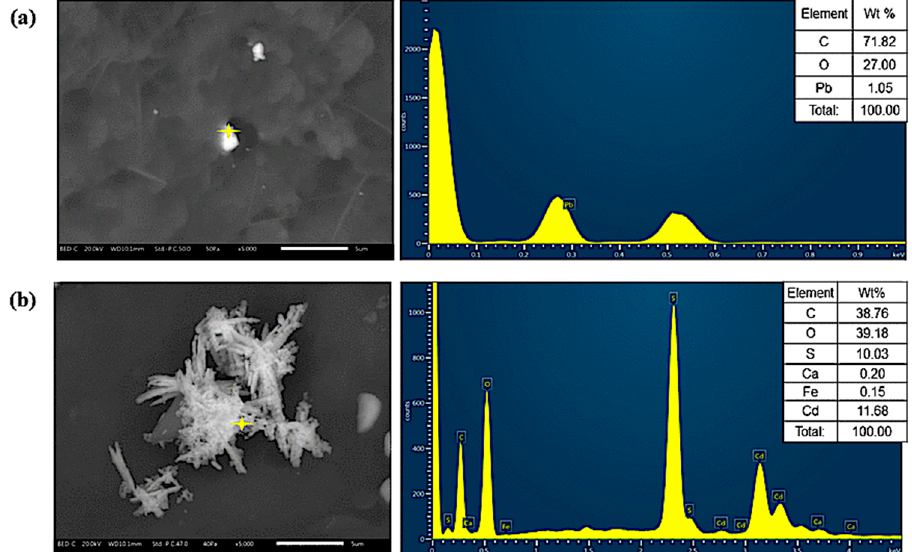
Figure 3. Spot analysis of composite samples after adsorption of ( a ) Pb and ( b ) Cd.